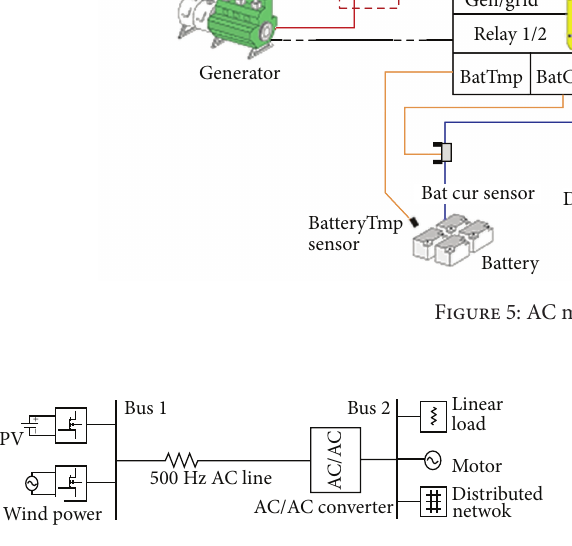
Figure 6: HFAC microgrid schematic chart [23].